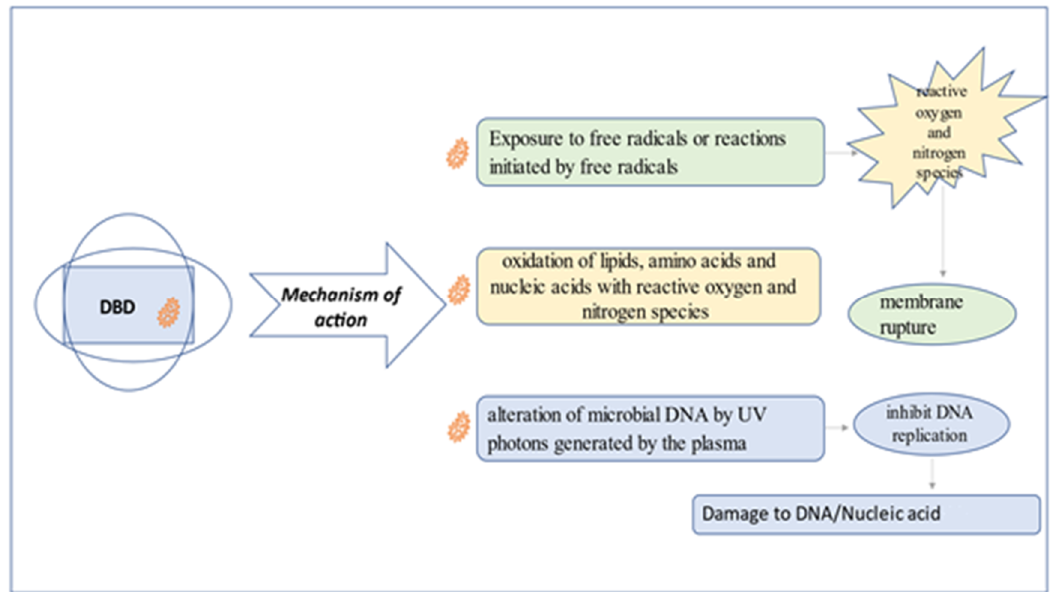
Figure 2. DBD mechanism of action in food for decontamination . Gram-positive and gram-negative bacteria respond differently to plasma